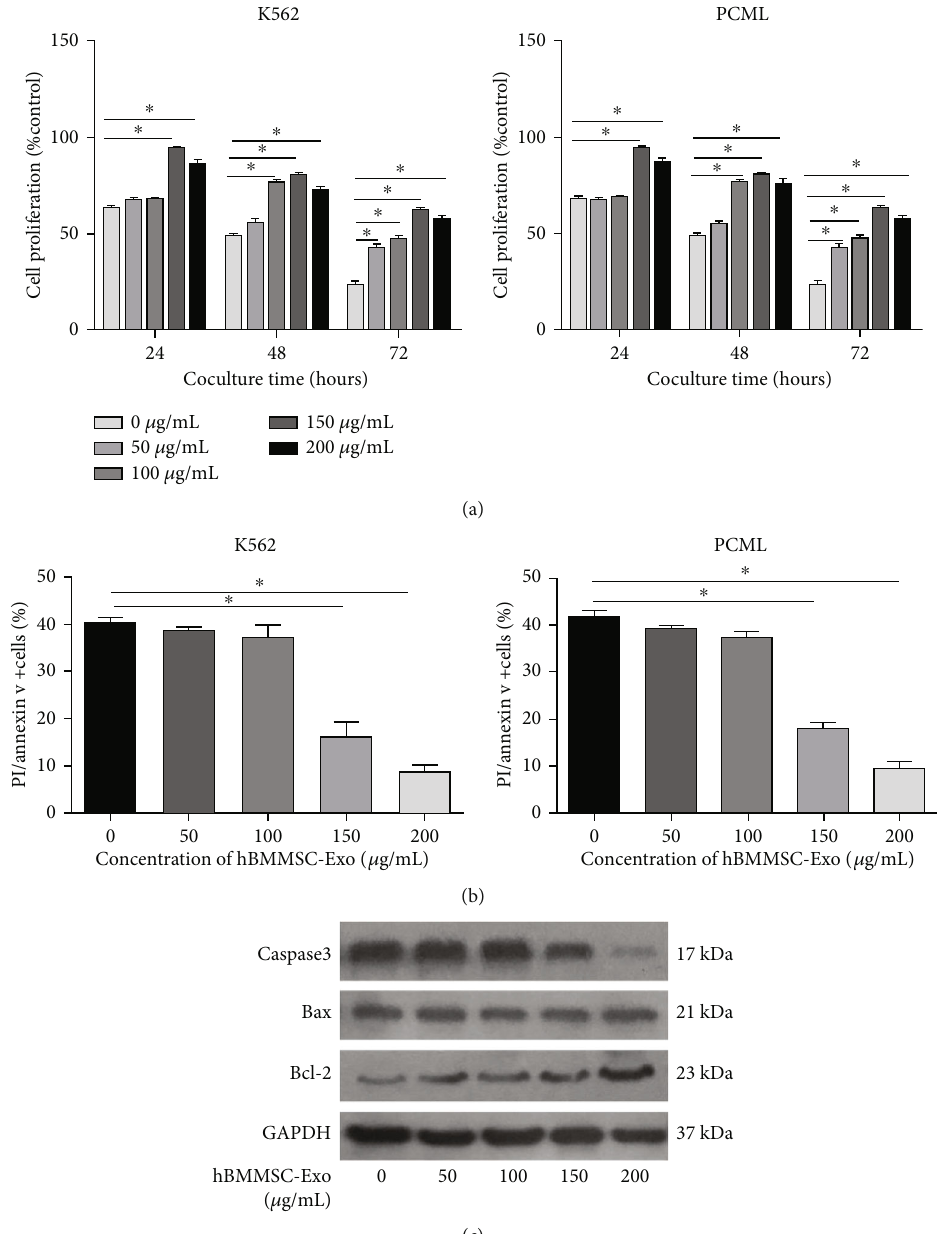
Figure 5: hBMMSC-Exo induce drug resistance in CML cells. (a) The proliferation of K562 and PCML cells after imatinib treatment (1 μ M) in the presence of di ff erent concentrations of hBMMSC-Exo (0, 50, 100, 150, and 200 μ g/mL) for 24, 48, and 72 h. (b) The apoptosis of K562 and PCML cells after imatinib treatment (1 μ M) in the presence of di ff erent concentrations of MSC-Exo (0, 50, 100, 150, and 200 μ g/mL) for 48h. (c) Representative blots and densitometry analysis of Caspase3, Bax, Bcl-2, and GAPDH in K562 cells after imatinib treatment (1 μ M) in the presence of di ff erent concentrations of hBMMSC-Exo (0, 50, 100, 150, and 200 μ g/mL) for 48h. The data were expressed as the mean ± SD of three independent experiments. ∗ p < 0 : 05 Student ’ s t